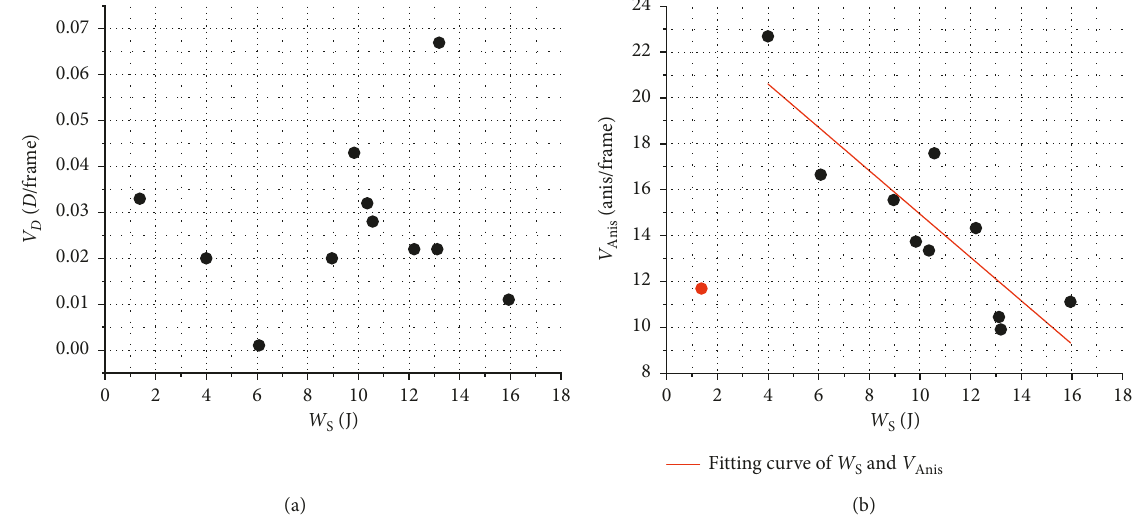
Figure 16: (a) Relationship between W